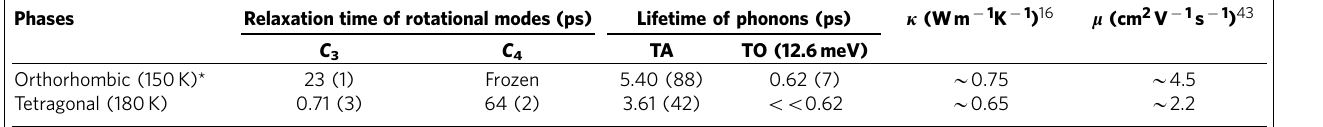
The orientational disorder of dipoles sets in at the transition, where lifetimes of optical phonons and mobility ( m ) undergo giant changes while acoustic phonons and thermal conductivity ( k ) are less susceptible. *Relaxation times of rotational modes for orthorhombic phase are taken at 140K.